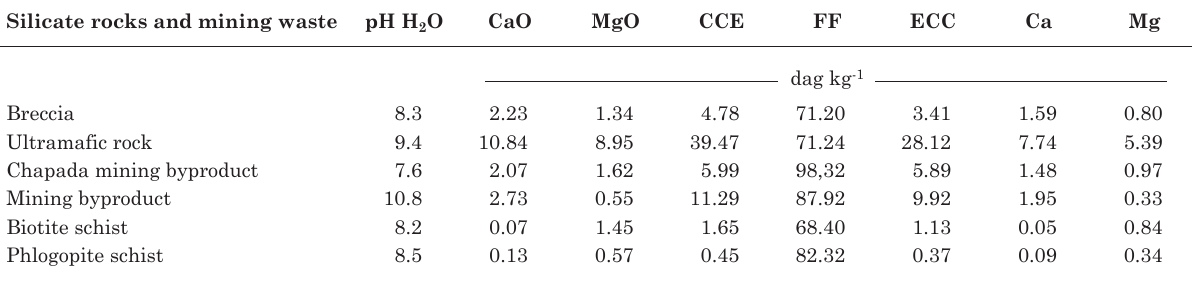
table 4. ph (h 2 o) of silicate rocks (1) , soluble Cao, mgo, calcium carbonate equivalent (CCe), fitness factor (ff), calcium and magnesium fitness factor and effective calcium carbonate (eCC) of the rocks and mining wastes (2)